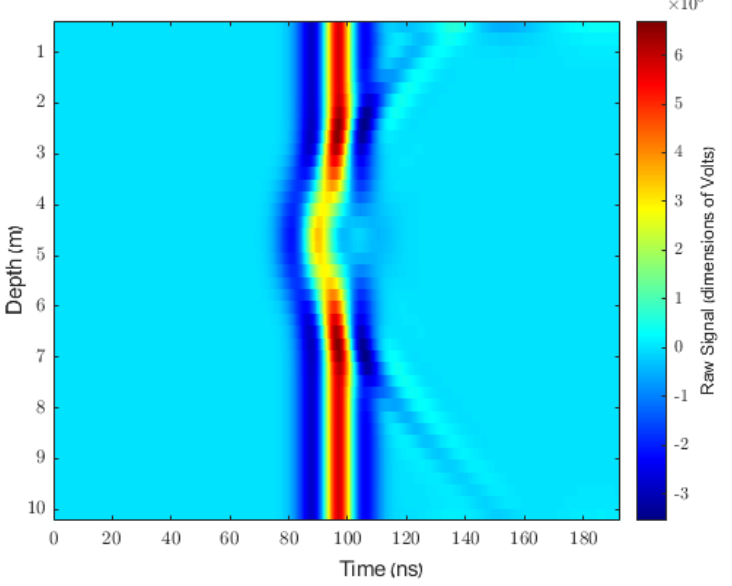
Figure 8. The profile taken over simulated homogenous soil as described in the text. The signals were cropped to show only the most relevant portions.